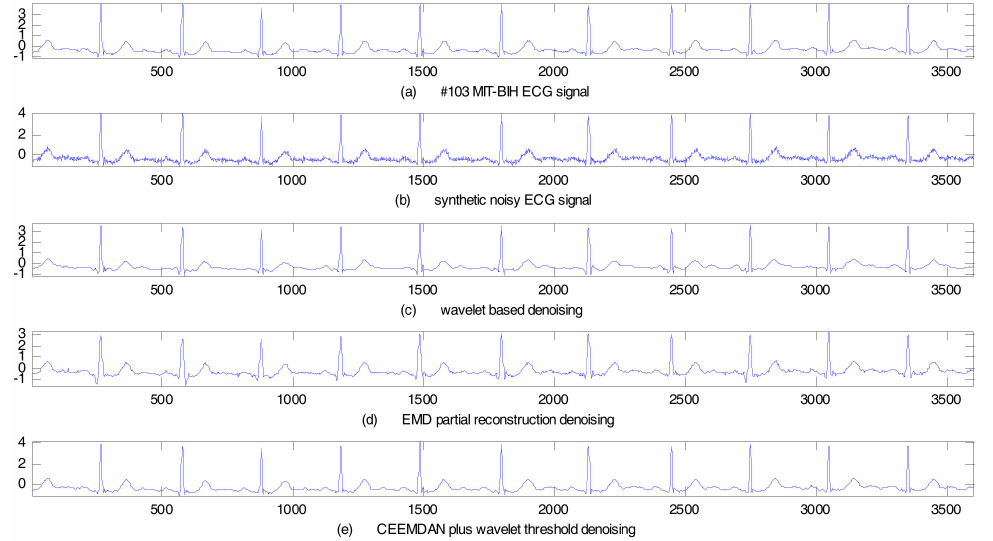
Figure 6. Synthetic noisy ECG signal de-noising results (No. 103 MIT-BIH